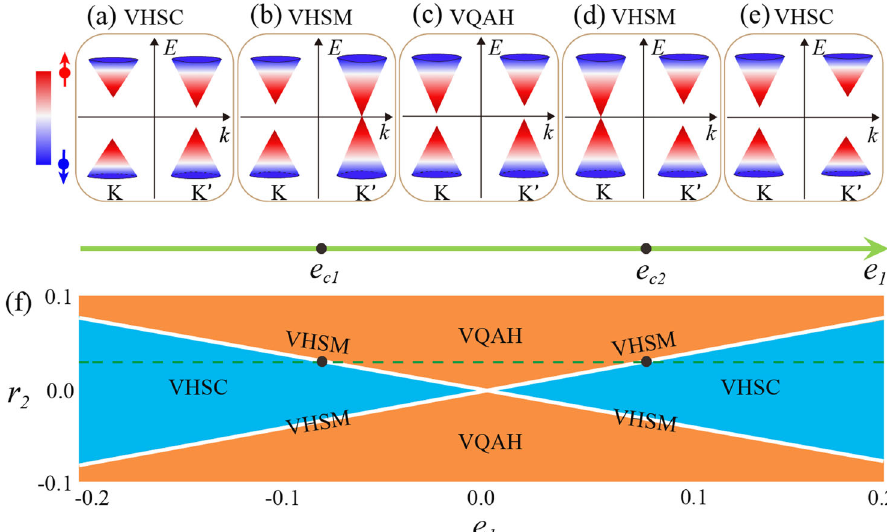
Fig. 1 Schematic diagrams of valley-dependent topological phase transitions. The balanced system is a valley-half-semiconductor (VHSC) state ( a ), which simultaneously exhibits valley polarized, full spin-polarized, and semiconducting properties. With increasing the parameter e 1 , K 0 and K valleys close successively at the critical points e c 1 and e c 2 respectively, corresponding to the valley-half-semimetal (VHSM) states ( b , d ), which simultaneously exhibits valley polarized, full spin-polarized, and semi-metallic properties. The fully spin-polarized valley-unbalanced quantum anomalous Hall states (VQAH) state ( c ) is expected between two VHSM states, which harbors valley index and quantum anomalous Hall effect simultaneously. Beyond e c 2 , the gap at K valley reopens and the VHSC state restores ( e ). A phase diagram as a function of the model parameters r 2 and e 1 ( r 1 = 2) is summarized in ( f